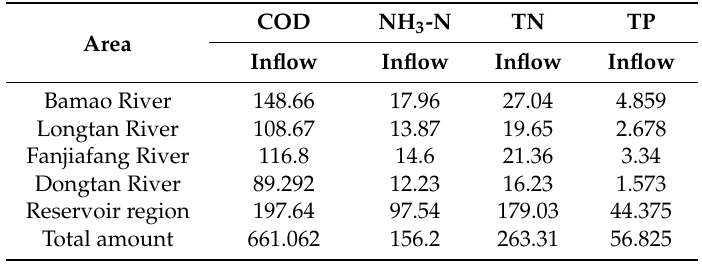
Table 7. The pollutant quantity inlets into the river in 2014 (units: tons/year).